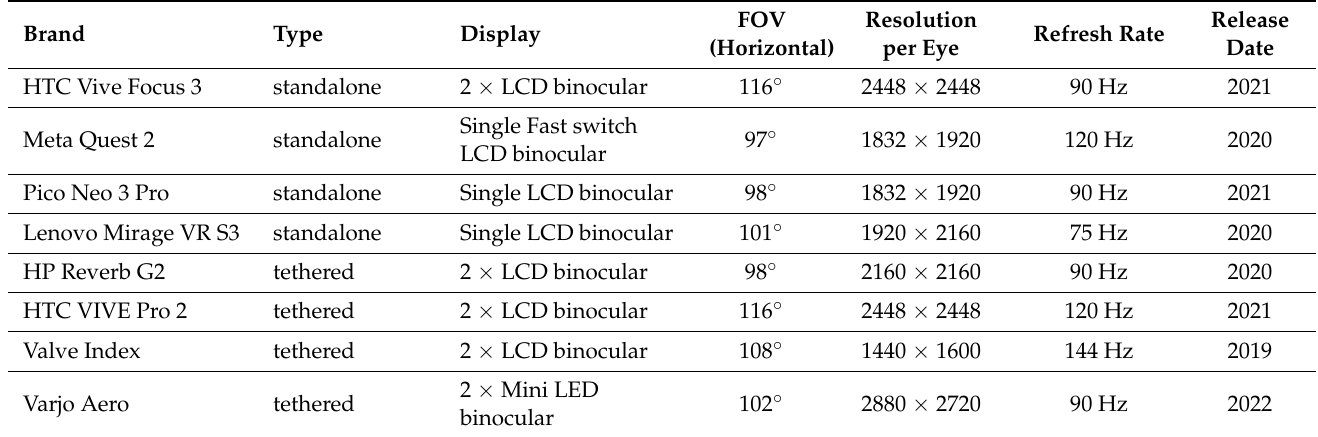
Table 6. Main VR tethered and standalone headsets on the market.